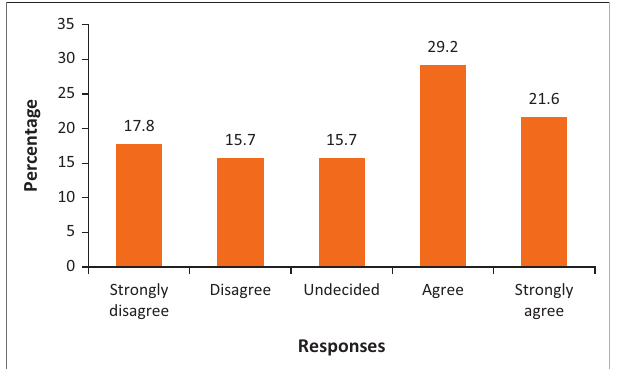
FIGURE 4: The infrastructure around the city is adequate to control traffic